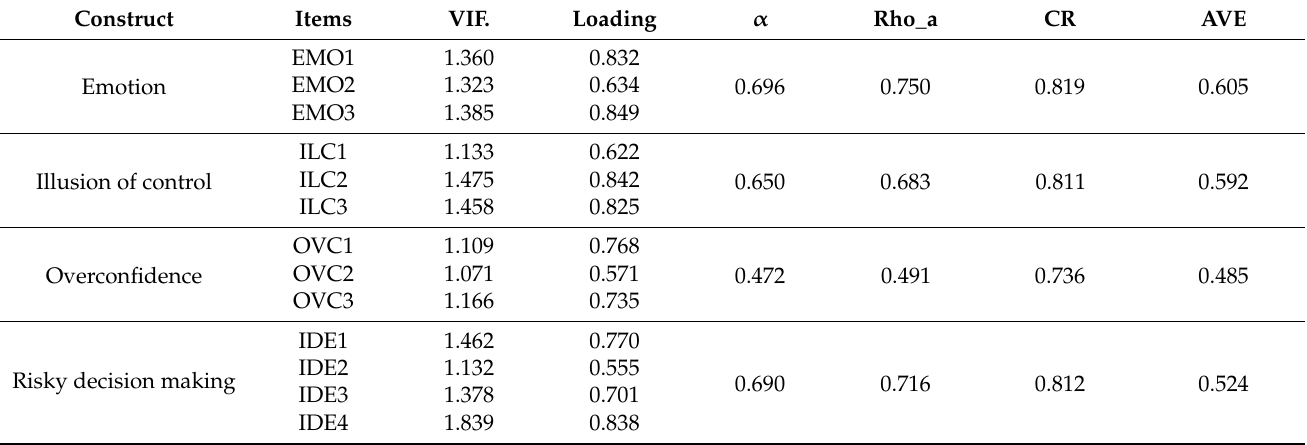
Table 3. Validity and reliability